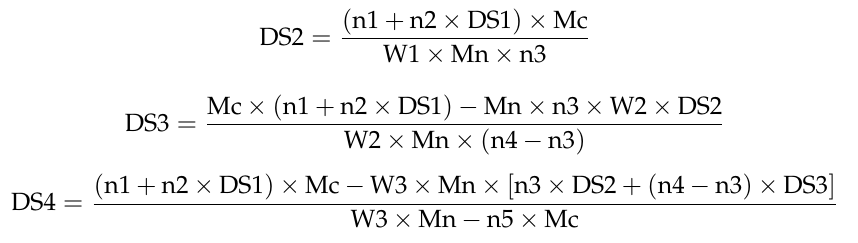
0.56 C: the mass percentage of carbon atom in the inulin derivatives. N: the mass percentage of nitrogen atom in the inulin derivatives. C/N: the mass ratio between carbon and nitrogen in the inulin derivatives (W1, W2, and W3). 2.4. Antifungal Assay The antifungal assay was evaluated against B. cinerea , F. oxysporum f.sp .niveum , and P. asparagi in vitro by measuring the growth rate of mycelium according to the method of Guo [35]. Briefly, the compounds (inulin and the inulin derivatives) were dissolved in distilled water at a concentration of 6.0 mg/mL at room temperature. Then, the test sample solution was added to the sterilized potato dextrose agar (PDA) medium to get a final concentration of 0.1, 0.5, 1.0, and 2.0 mg/mL, respectively, and then the solution was poured into the sterilized Petri dishes (6.0 cm). Identical volume distilled water substituting samples were poured into control plates. Finally, the fungi mycelia disk with a diameter of 5.0 mm was placed into the center of the PDA Petri dishes and incubated at 27 °C for 2–3 days. When the diameter of the fungi mycelium reached to the edges of the control plate (without the sample), the inhibitory index was calculated as follows: